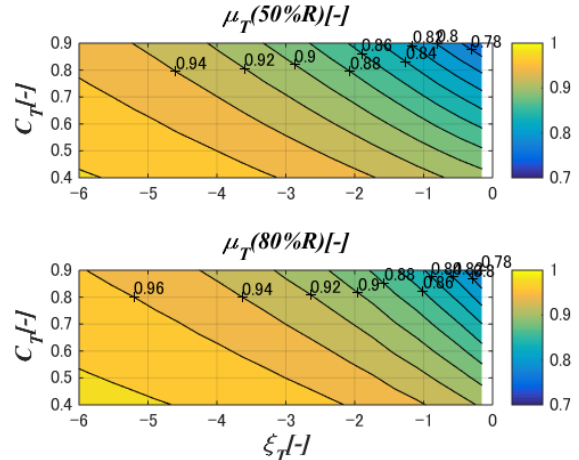
Figure 11. Wind speed in front of the rotor as obtained by CFD. μ T , normalized wind speed, ξ T , normalized distance.